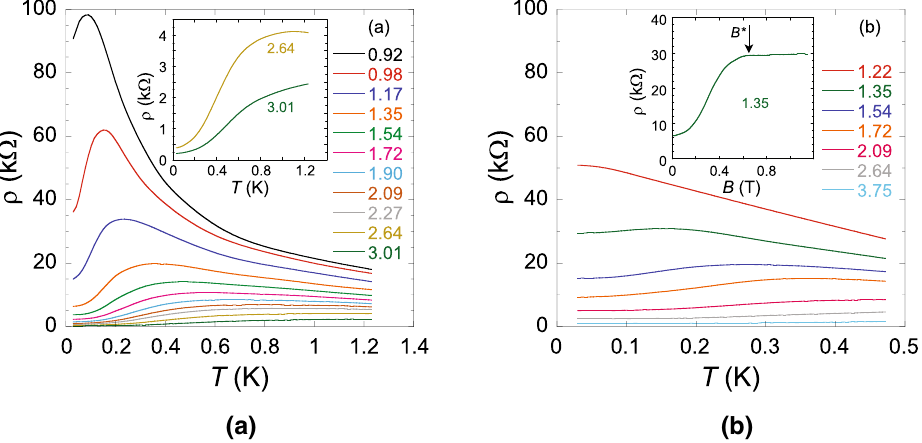
Figure 1. Non-monotonic temperature dependences of the resistivity of the 2D electron system in SiGe/Si/ SiGe quantum wells on the metallic side near the metal-insulator transition ( a ) in B = 0 and ( b ) in B = B ∗ ; the magnetic fields used are spanned in the range between approximately 1 and 2 T. The electron densities are indicated in units of 10 10 cm − 2 . The inset in ( a ) shows ρ( T ) at n s = 2.64 and 3.01 × 10 10 cm − 2 on an expanded scale. The inset in ( b ) shows the parallel-field magnetoresistance at n s = 1.35 × 10 10 cm − 2 at T ≈ 25 mK. The polarization field B ∗ is